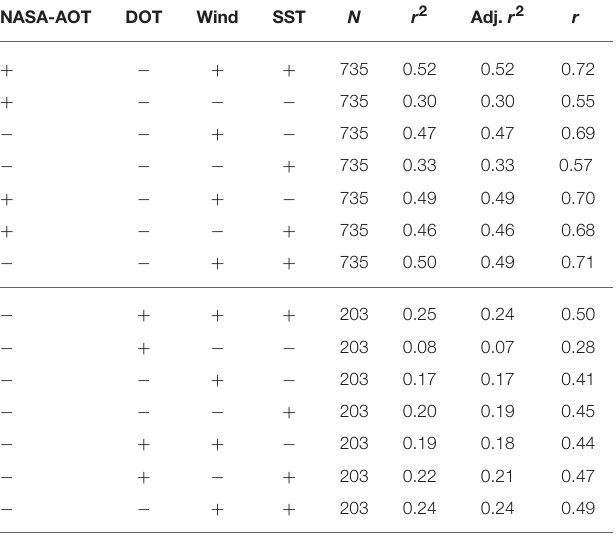
TABLE 4 | Results of multiple linear regression analysis with Chl-a as the dependent variable and NASA-AOT or DOT, alongshore wind speed and SST as independent variables for 1 time step lag. NASA-AOT